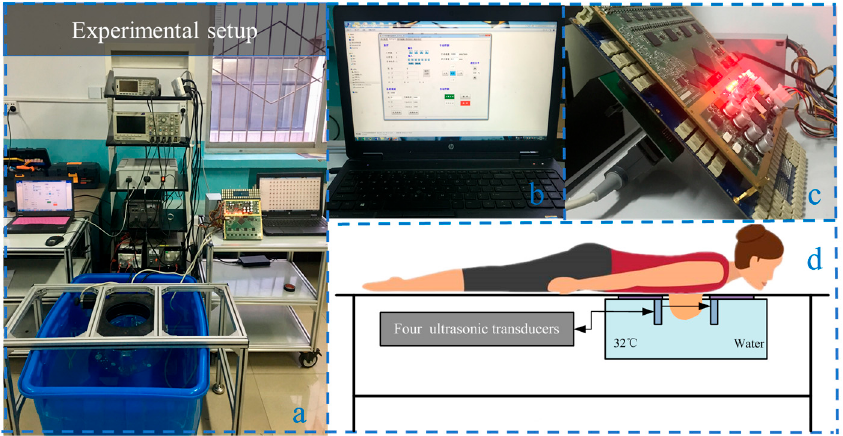
Figure 9. Ultrasonic horizonal tomography images using this setup. ( a ) Slice N = 2. ( b ) Slice N = 15. ( c ) Slice N = 25. ( d ) Slice N = 40. ( e ) Slice N = 50. ( f ) Slice N = 72.